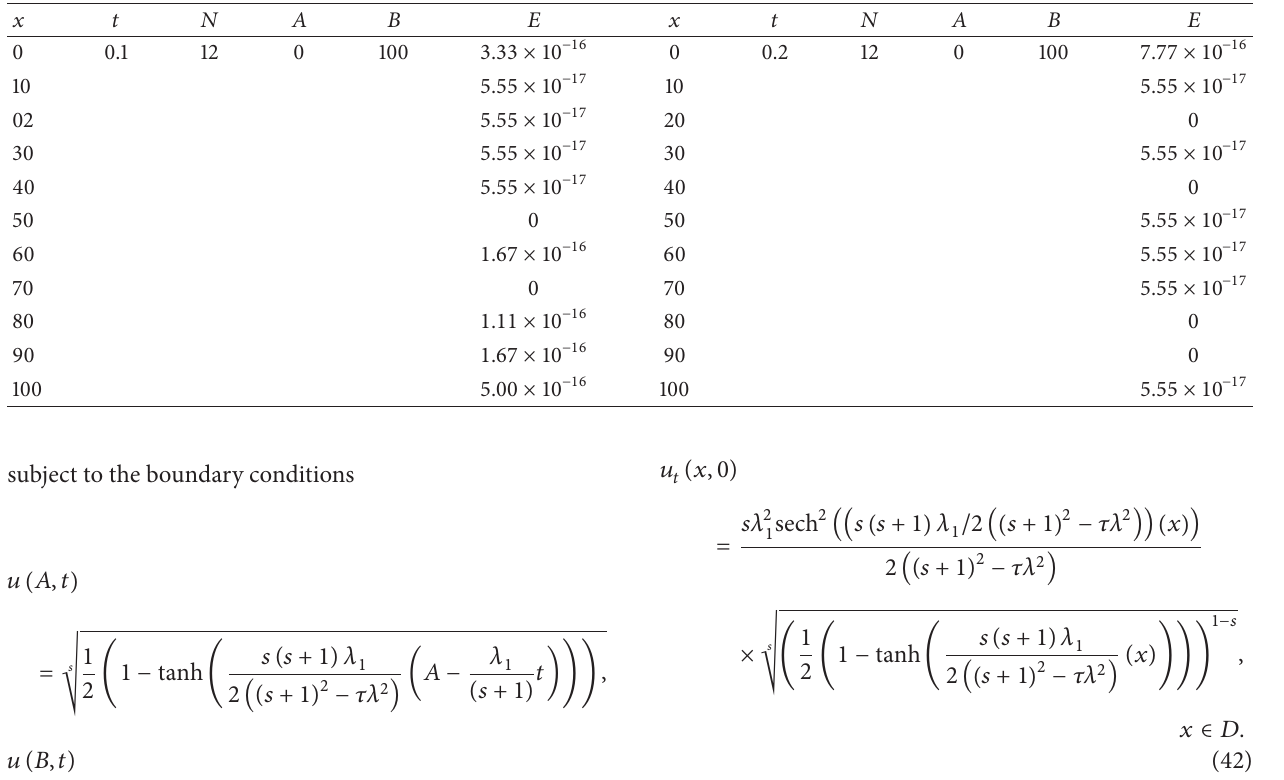
Table 2: Absolute errors with 𝜃 = 𝜗 = 1/2 , 𝑁 = 12 and various choices of 𝑥, 𝑡 with 𝜏 = 0.5 and 𝜆 1 = 0.01 for Example